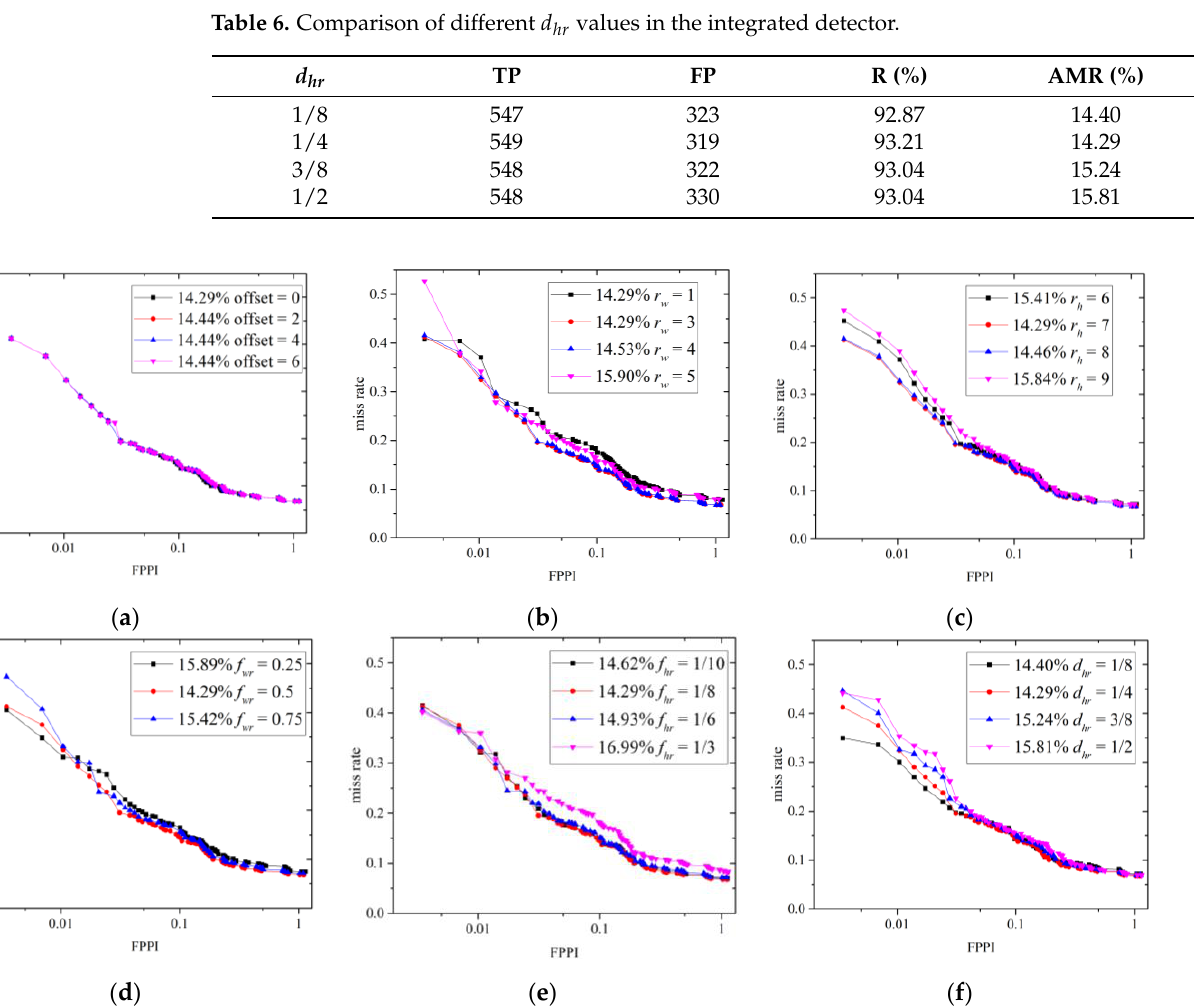
Figure 18. Miss rate versus FPPI for different choices of 𝑜𝑓𝑓𝑠𝑒𝑡 ( a ), 𝑟 𝑤 ( b ), 𝑟 ℎ ( c ), 𝑓 𝑤𝑟 ( d ), 𝑓 ℎ𝑟 ( e ), and 𝑑 ℎ𝑟 ( f ).